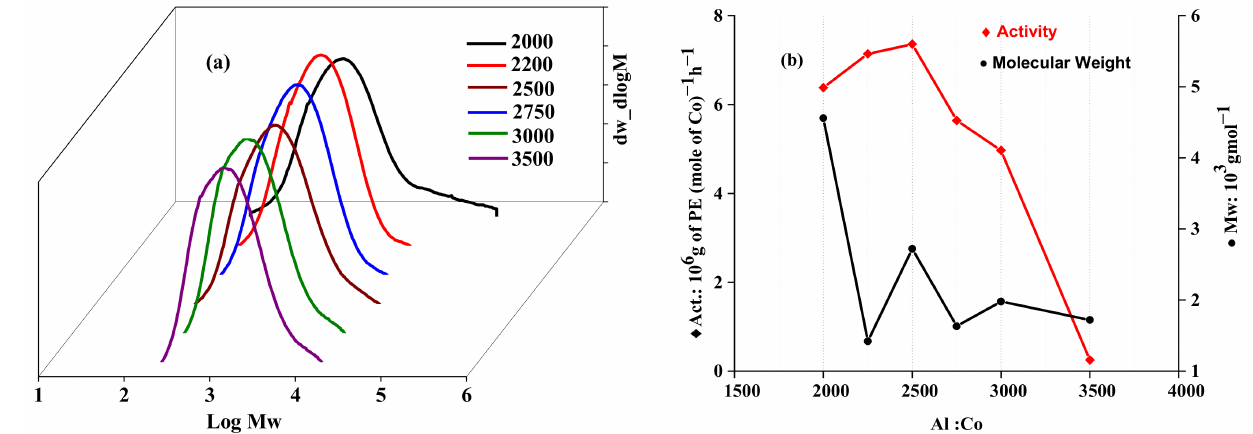
Figure 4. GPC curves of the obtained polyethylene ( a ); activity and M w as a function of Al/Co ratio ( b ) for the Co1 /MAO system (Table 2, entries 2, 6–10).